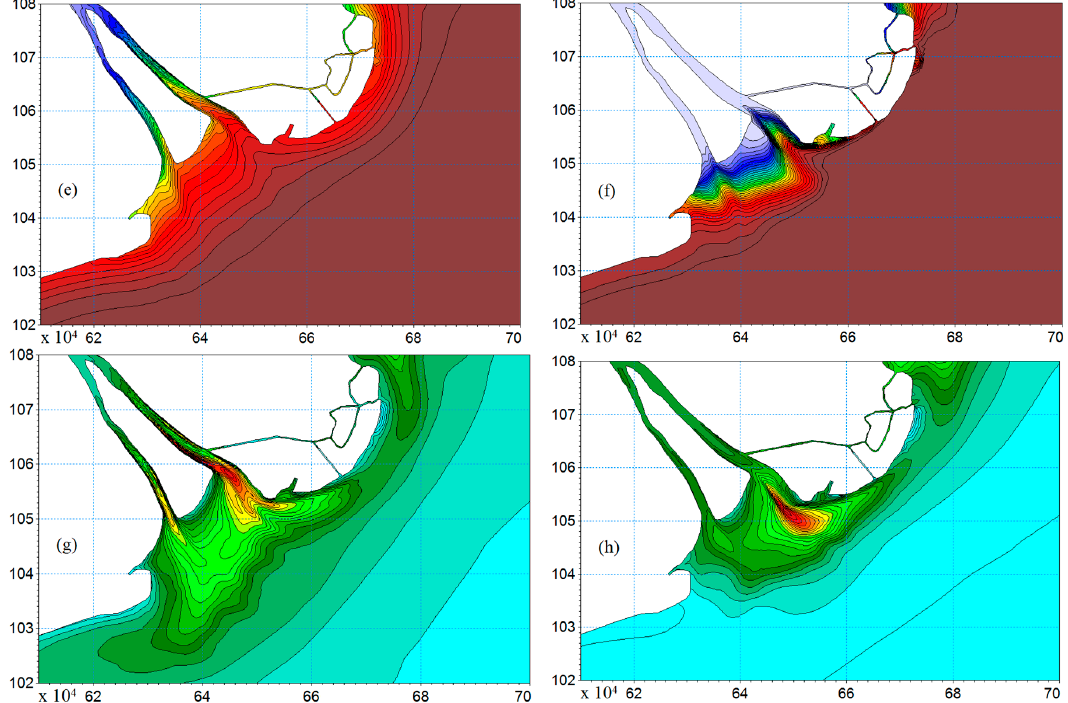
Figure 10. Spatial distribution of salinity (psu) and SSC (g L − 1 ) at high tide; ( a , b ) salinity in the dry and flood seasons in the surface layer; ( c , d ) SSC in the dry and flood seasons in the surface layer; ( e , f ) salinity in the dry and flood seasons in the bottom layer; ( g , h ) SSC in the dry and flood seasons in the bottom layer. Color scale is the same as in Figure 8.